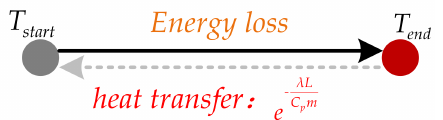
Figure 2. Temperature constraint between two